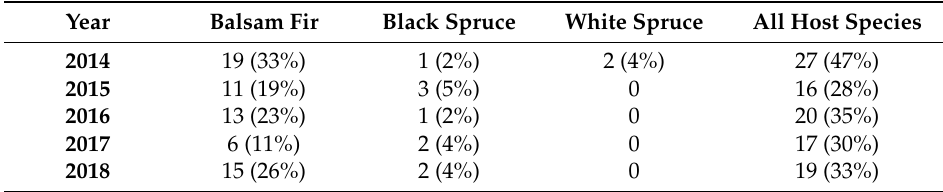
Table 3. Number and percentage of plots with significantly clustered patterns of defoliation of trees, based on global Moran’s I analyses among years, for balsam fir, black spruce, white spruce, and all host species in each plot ( α = 0.05, search radius = 5 m). Year Balsam Fir Black Spruce White Spruce All Host